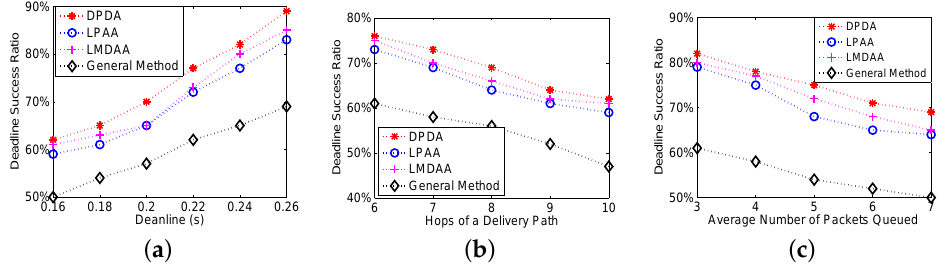
Figure 3. Deadline Success Ratio (DSR) of the proposed algorithms. ( a ) DSR vs. deadlines; ( b ) DSR vs. the number of hops; ( c ) DSR vs . the average number of packets queued.